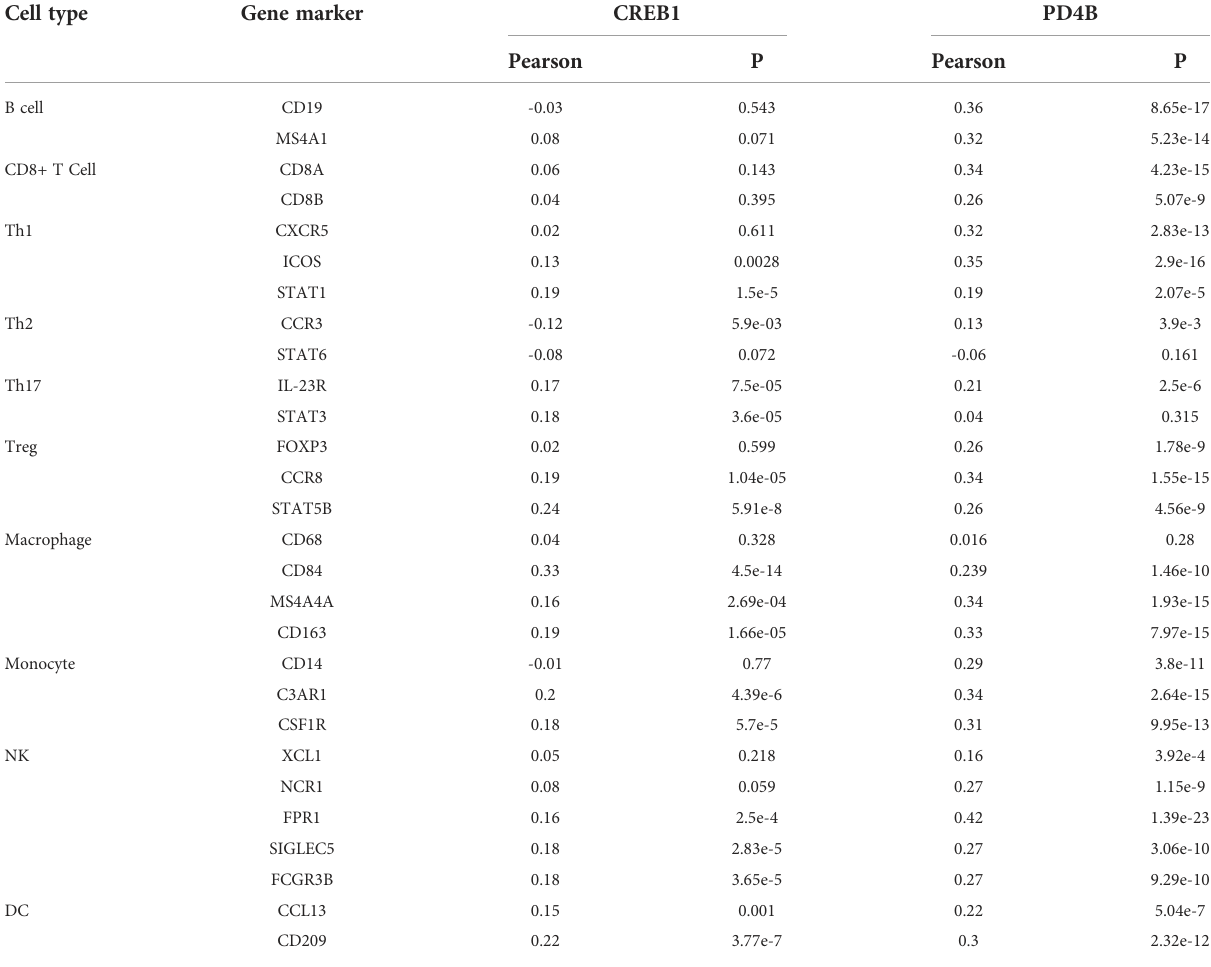
TABLE 1 Correlation analysis between CREB1 and PDE4B and relate markers of immune